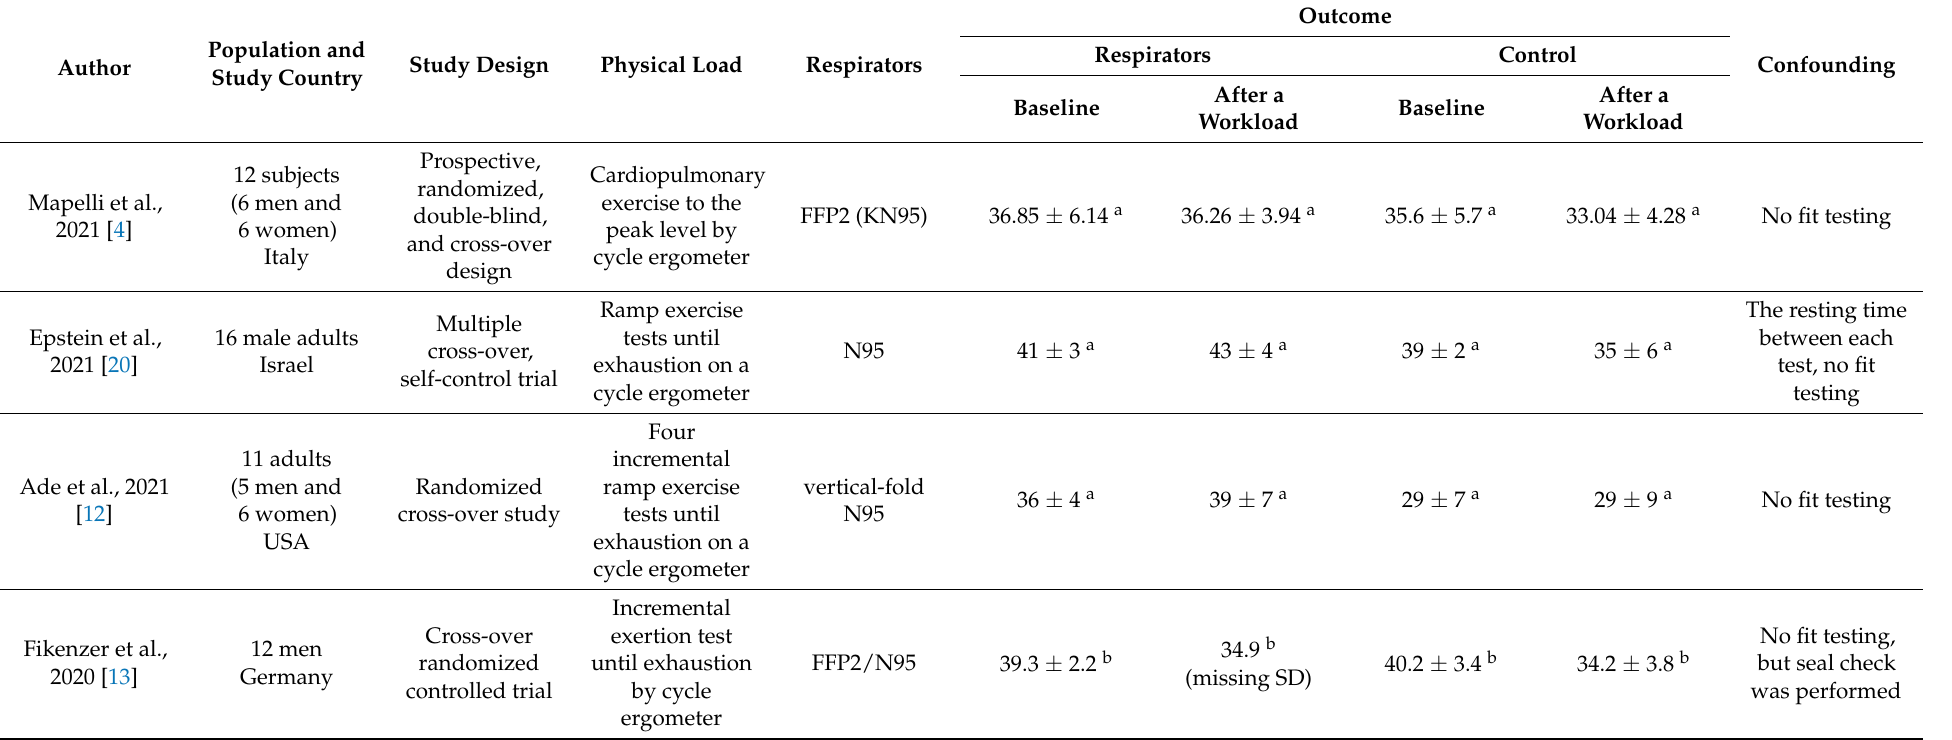
Table 3. Partial Pressure of Carbon Dioxide in High Physical